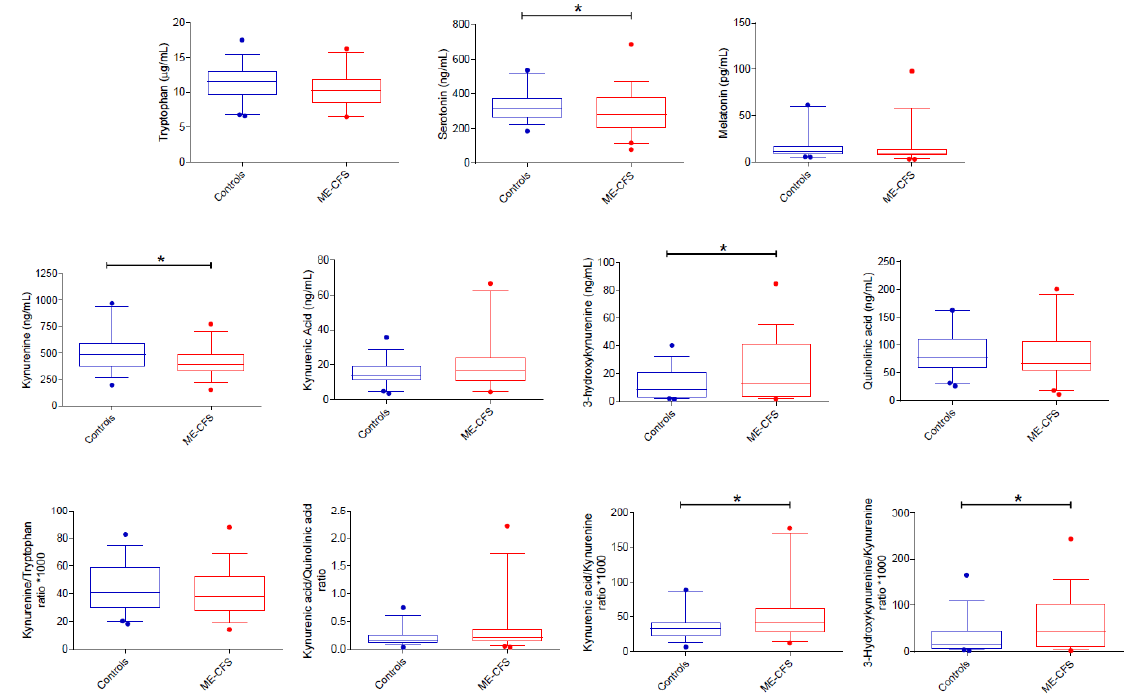
Figure 3. Case-control comparison of tryptophan metabolites via serotonin and kynurenine ( n = 39). Serum levels of serotonin and kynurenine are lower and those of 3-hydroxykynurenine higher in ME-CFS patients than in controls. The kynurenic acid/kynurenine and 3-hydroxykynurenine/kynurenine ratios, indirect measures of kynurenine aminotransferases and kynurenine 3-monooxygenase enzymatic activities, respectively, are higher in ME-CFS patients than in controls. Data are presented as boxplots with median and interquartile ranges and 5 – 95 percentiles. Black dots represent data outside the 5 – 95 percentiles. * p < 0.05; Quade’s rank analysis of covariance with BMI, sex , and age as covariates.